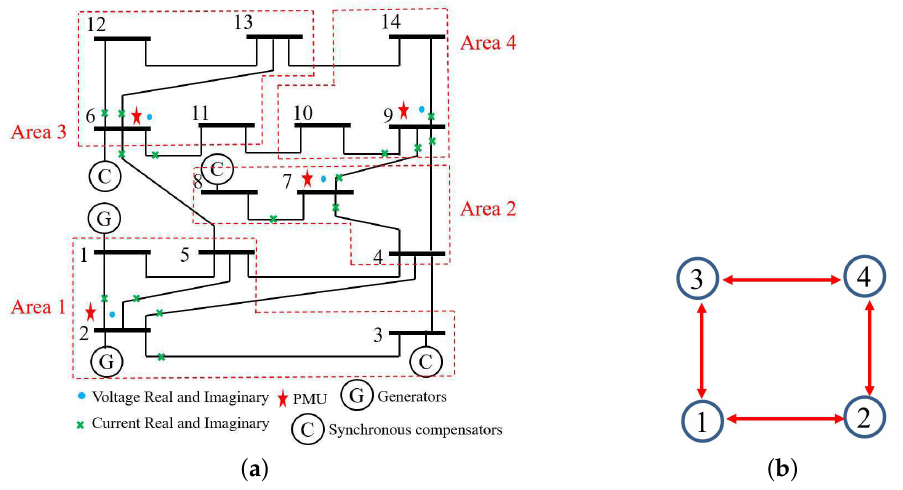
Figure 8. ( a ) The IEEE 14-bus system installed with minimum number of PMUs. ( b ) The communication scheme related to the partitioned type.